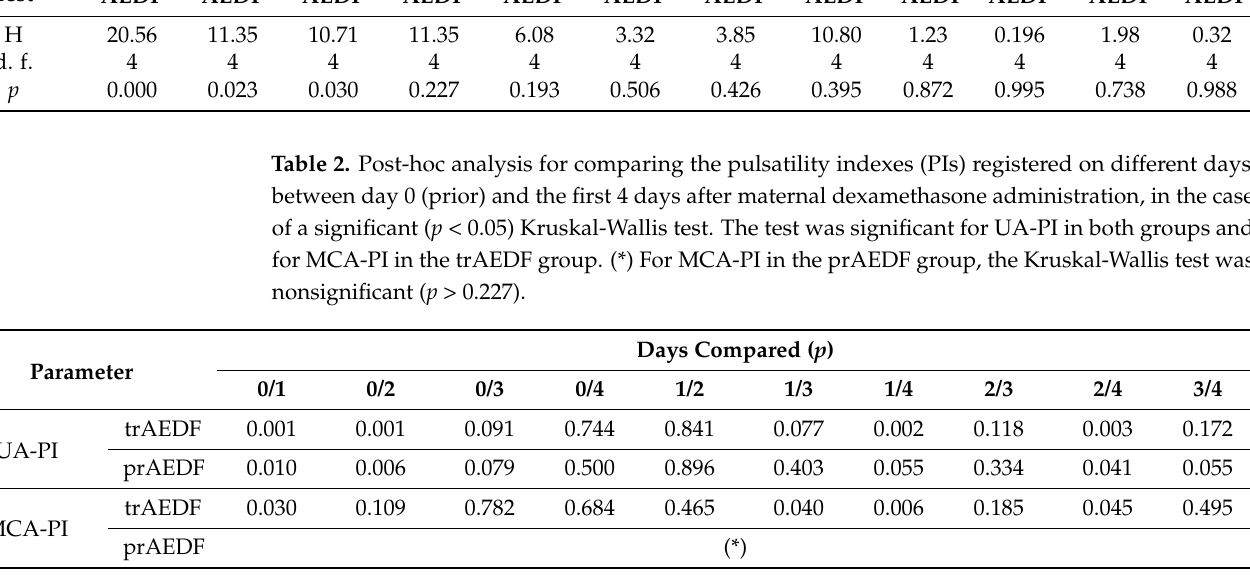
Table 3. The characteristics of the pulsatility index in the umbilical artery (UA-PI) prior (day 0) and in the first 4 days after maternal dexamethasone administration in the two